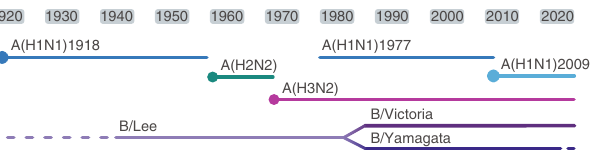
Fig. 6 Historical circulation of in fl uenza viruses in the last century. Dots indicate emergence of pandemic strains that replaced previously circulating in fl uenza